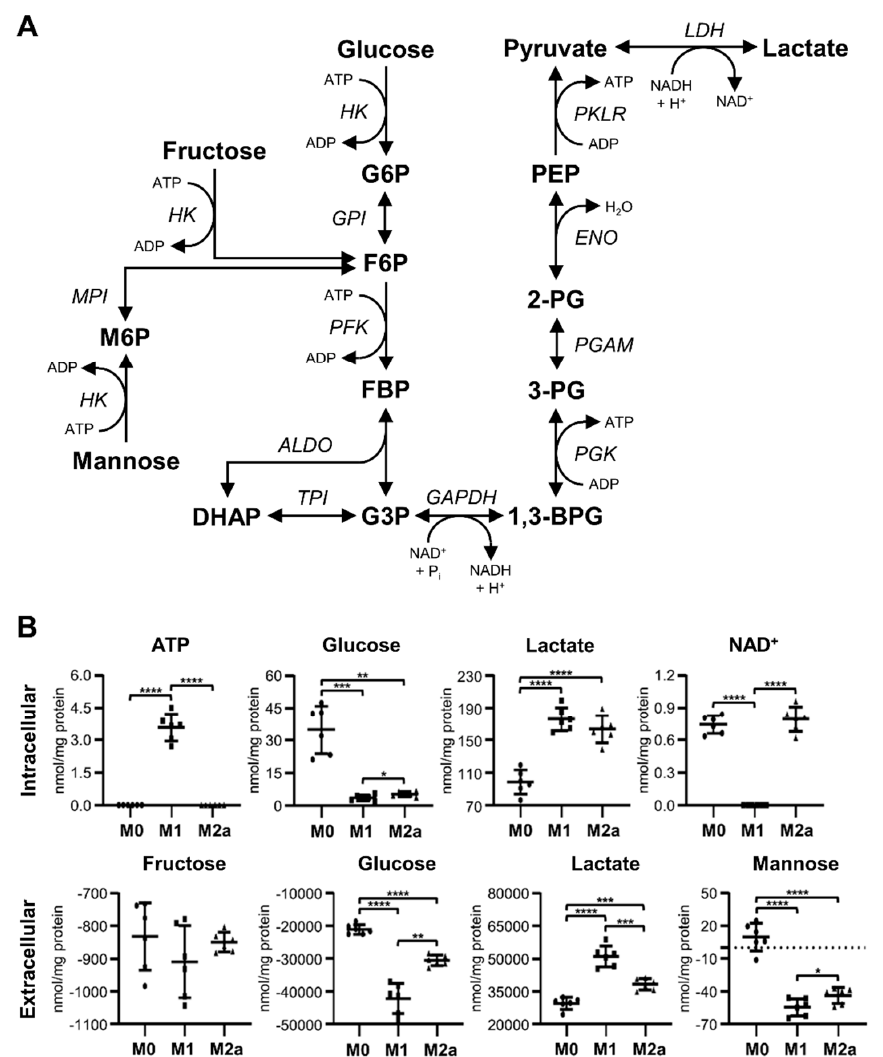
Figure 2. Increased glycolytic activity and lactate production are universal markers of M Φ activation. Schematic diagram of glycolysis and lactic acid fermentation pathways ( A ), and quantitative levels of corresponding metabolites ( B ) detected in intra- and extracellular M Φ metabolite extracts (mean ± SD). Unpaired parametric t -tests with Welch’s correction (two-tailed; * p < 0.05; ** p < 0.01; *** p < 0.001; **** p < 0.0001). Abbreviations denote: 2-PG, 2-phosphoglycerate; 3-PG, 3-phosphoglycerate; ADP,